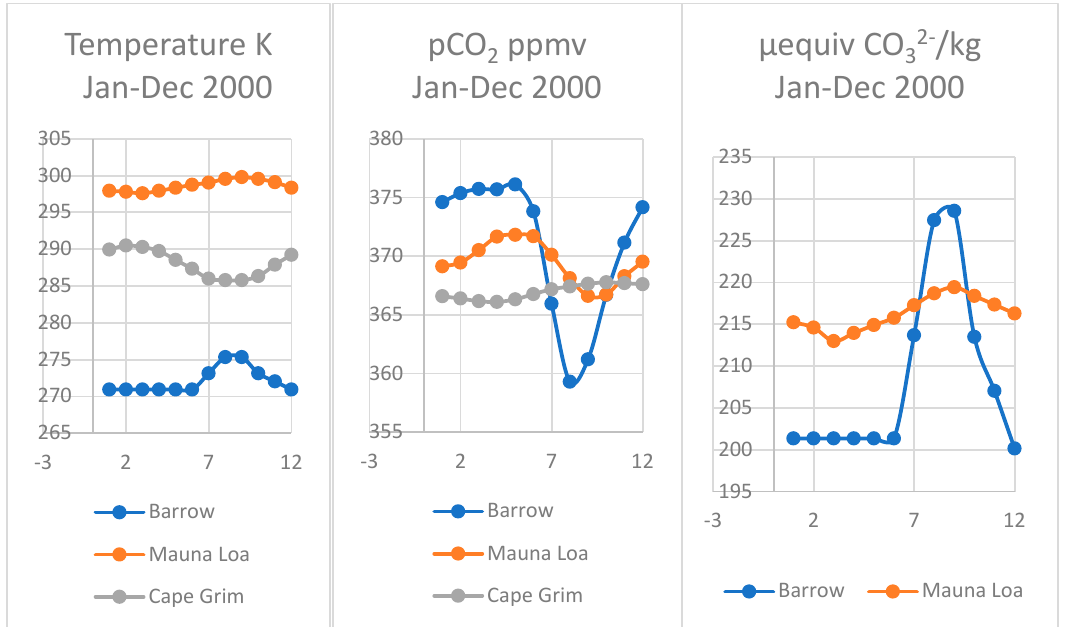
Figure 7. Comparison of actual data recorded for surface seawater temperature and f CO 2 and estimated carbonate using the Thermal model for seawater at Point Barrow Alaska Mauna Loa Hawaii, (Keeling et al., 2009) and near Cape Grim (CSIRO) at Smithton, Tasmania.